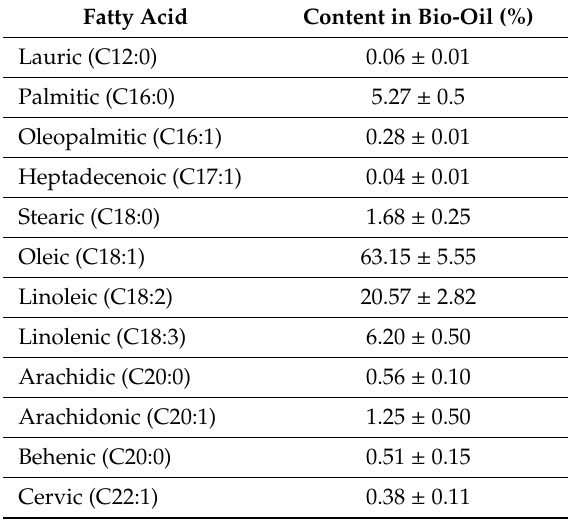
Table 6. The characteristics of the fatty acid methyl esters (FAME) in the bio-oil obtained from the microalgae biomass.